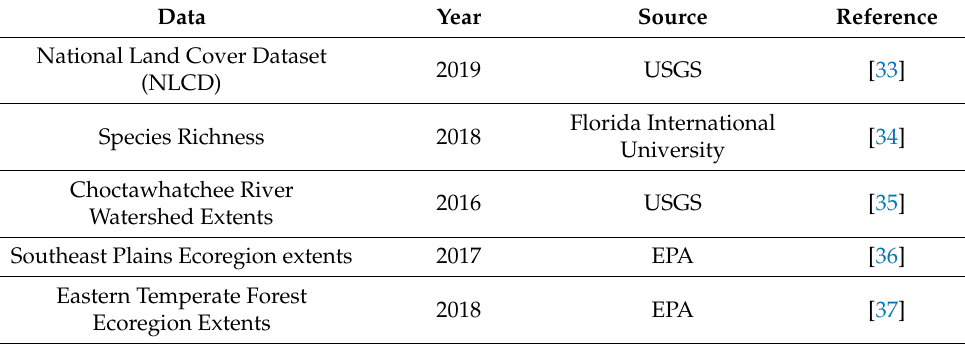
Table 1. The details of the spatial data used in the study.